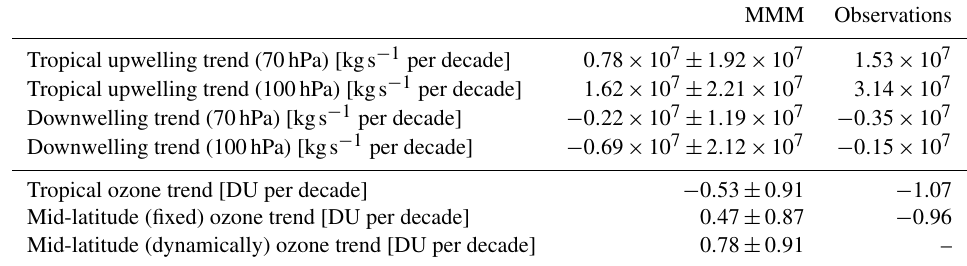
Figure 6. Vertical profile of the inter-model correlation coefficients for (a) tropical upwelling (20 ◦ N–20 ◦ S) trends (kgs − 1 per decade) to tropical (red line) and northern mid-latitude (blue line) LS ozone column trends and for (b) mid-latitude downwelling mass flux (between the turnaround latitudes and 50 ◦ N) trends (kgs − 1 per decade) to tropical and northern mid-latitude LS ozone column trends. Correlations are calculated for upwelling and downwelling trends between 10 and 150hPa. Mid-latitude ozone trends are averaged over the latitude band of 30–50 ◦ N (solid blue line) and also over the dynamically defined latitude band between the turnaround latitudes to 50 ◦ N (dashed blue line). Trends are calculated over the period 1998–2018 for a subset of 20 REF-C2 simulations. Correlation coefficients which are significant on the 95% level are highlighted in bold. Table 2. MMM and observational ozone trends, calculated over the period 1998–2018 for tropical upwelling at 70 and 100hPa, for ex- tratropical downwelling at 70 and 100hPa, for the LS tropical ozone column, and for the northern mid-latitude ozone column. Note that LS mid-latitude ozone trends are averaged over the fixed latitude band of 30–50 ◦ N and also over the dynamically defined latitude band between the turnaround latitudes to 50 ◦ N. MMM trends and their standard deviation are given over a subset of 20 REF-C2 simulations. Observation-based data for up- and downwelling are taken from ERA5 reanalysis and observational data for ozone from BASIC SG . MMM